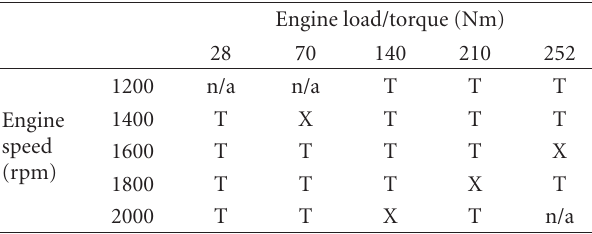
Table 3: Data set assignment. (T and X refer to training sets and test sets, resp.)